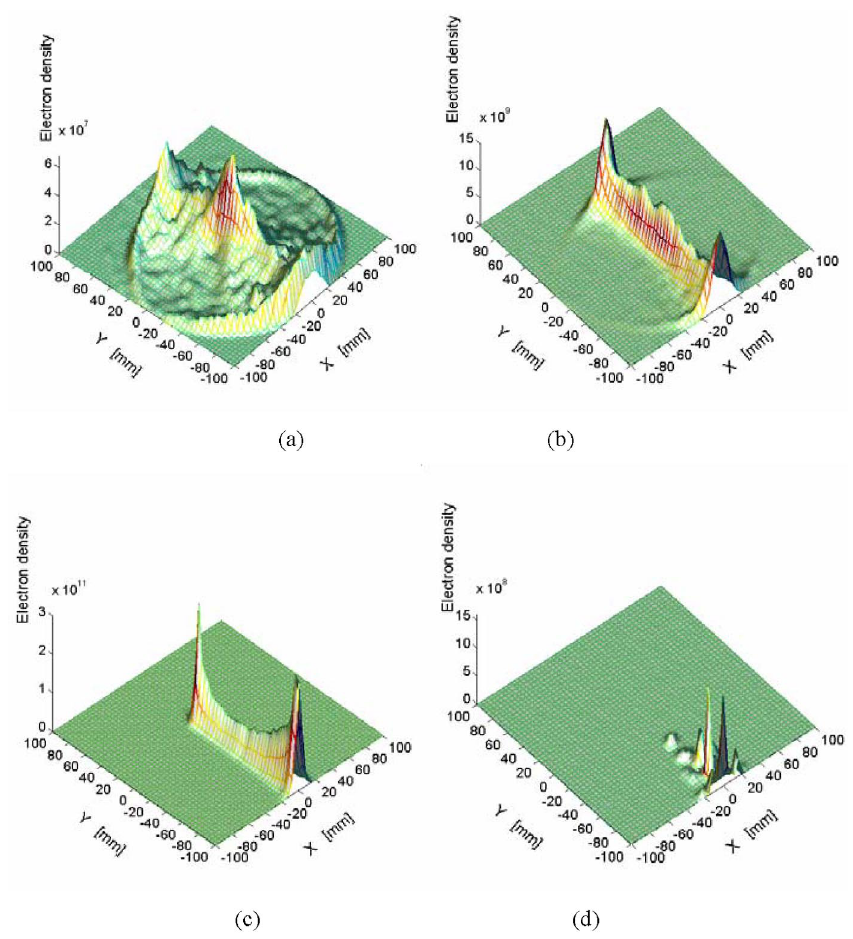
FIG. 9. (Color) Electron distribution in the transverse plane with 2000 Vclearing potentials at different times (a) 350 ns, (b) 560 ns, (c) 630 ns, and (d) 700 ns.